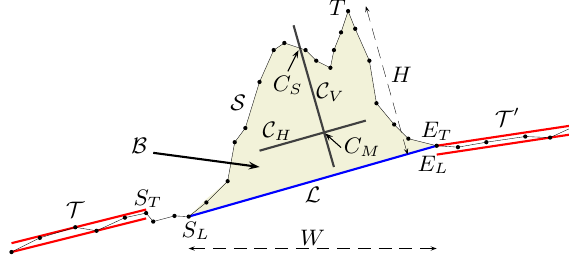
Figure 4. Bump model